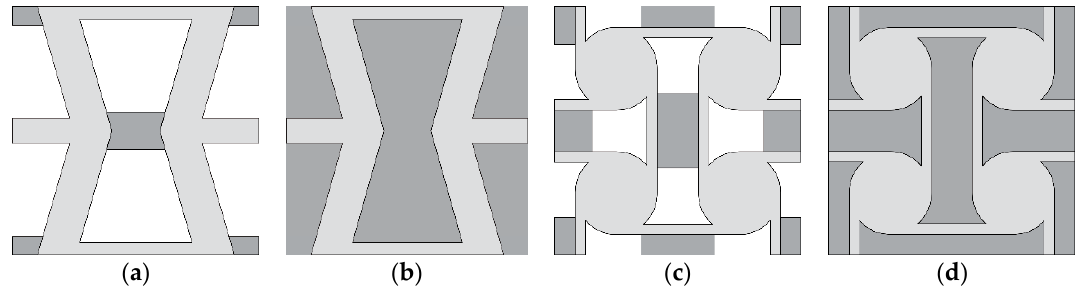
Figure 1. Analyzed auxetic unit cells (light gray) with linking/filling material (dark gray): ( a ) modified re-entrant honeycomb; ( b ) filled re-entrant honeycomb; ( c ) modified anti-tetrachiral; ( d ) filled anti-tetrachiral.